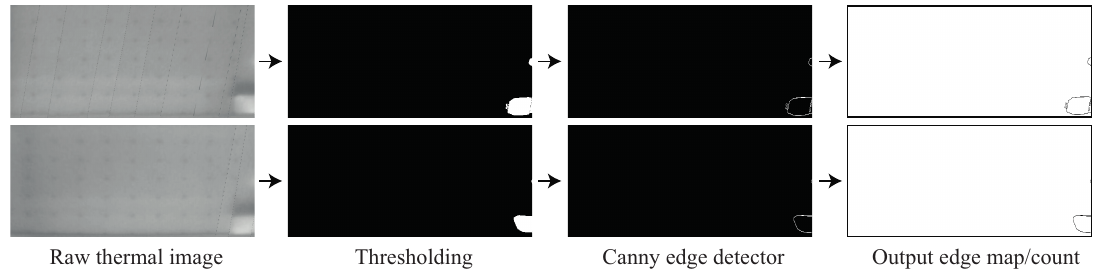
Figure 17. Results of Canny edge detection and output edge map/count applied to: module 5 and 6.